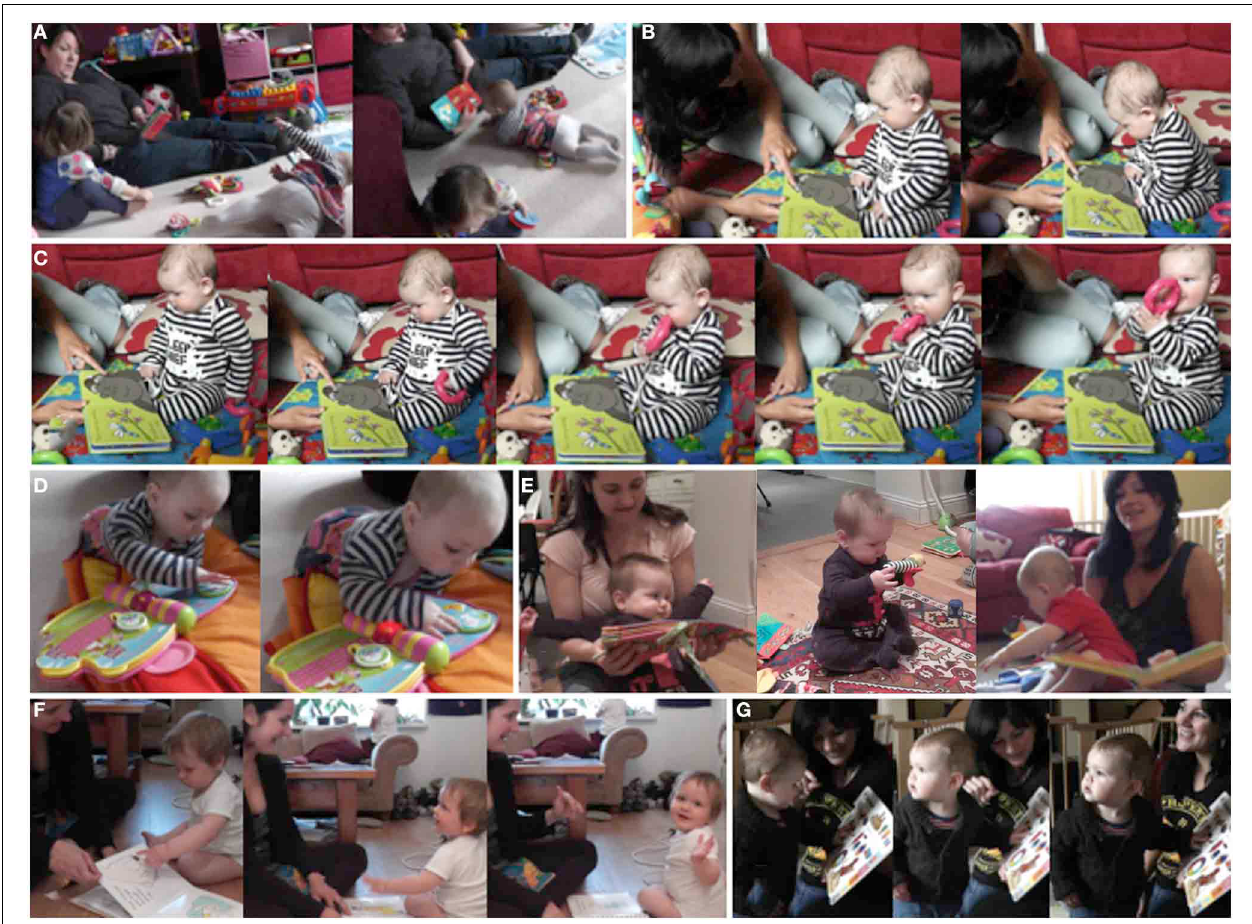
FIGURE 11 | (A) 7-month-old infant initiating book sharing by crawling toward the book. (B) 6-month-old, sitting freely, focusing on mother’s dynamical pointing and further closing in. (C) the 6-month-old in the same interaction getting distracted after accidentally touching and subsequently grasping and mouthing a toy ring. (D) 7-month-old absorbed in solitary play: correctly operating interaction device resulting in music and blinking. (E) 9-month-olds escaping from the book sharing activity despite their mother’s attempts to engage them. (F)